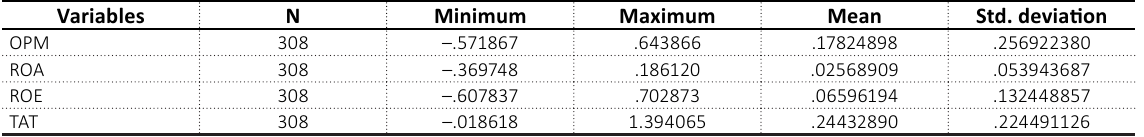
Table 3. Descriptive statistics